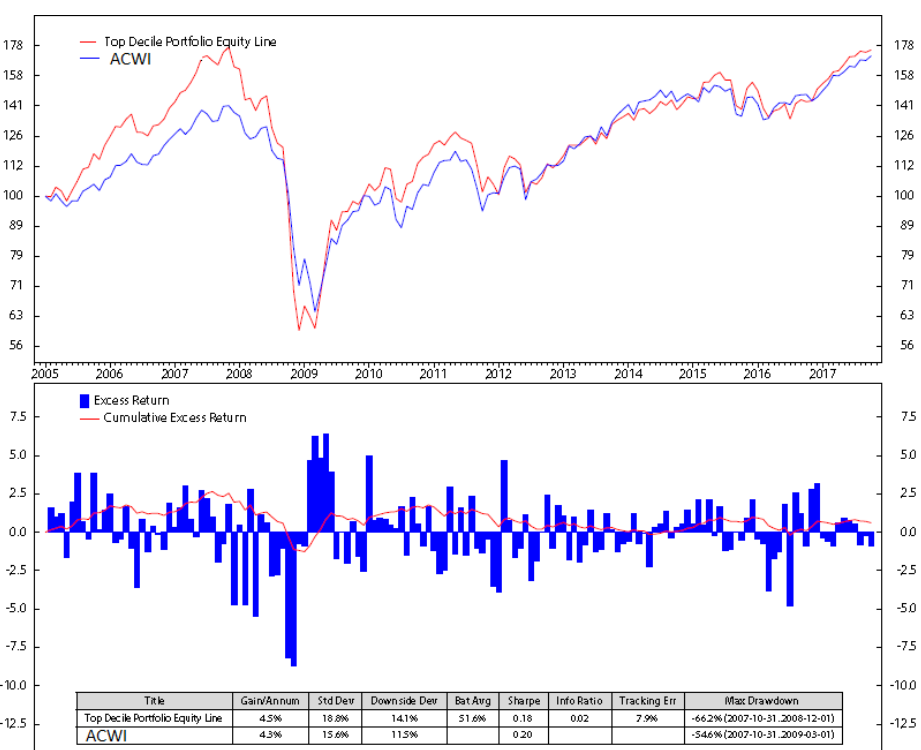
Figure A10. Global stock selection from January 2005 to September 2017 based on stock long-term earning per share growth